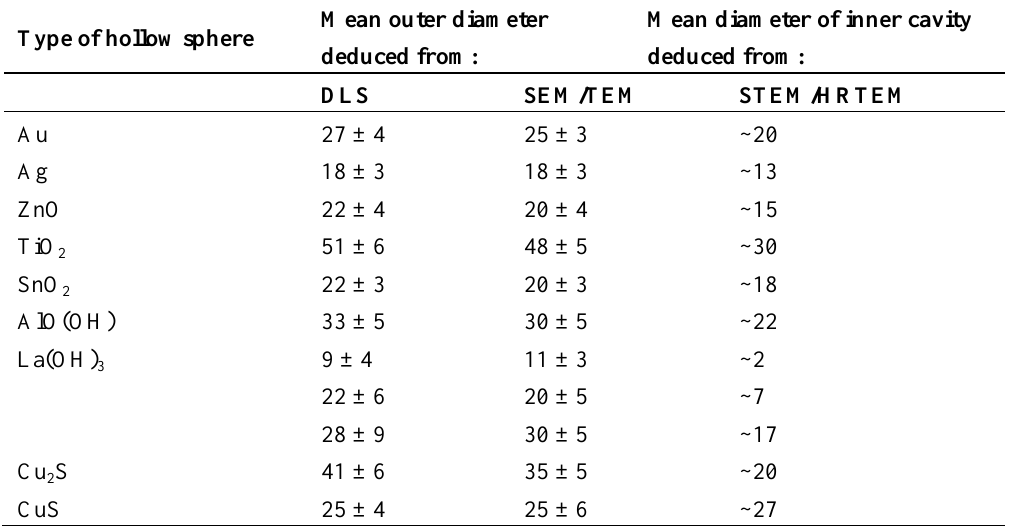
Table 2. Outer diameter and cavity size of various hollow spheres as made via the microemulsion approach. All values given in /nm.